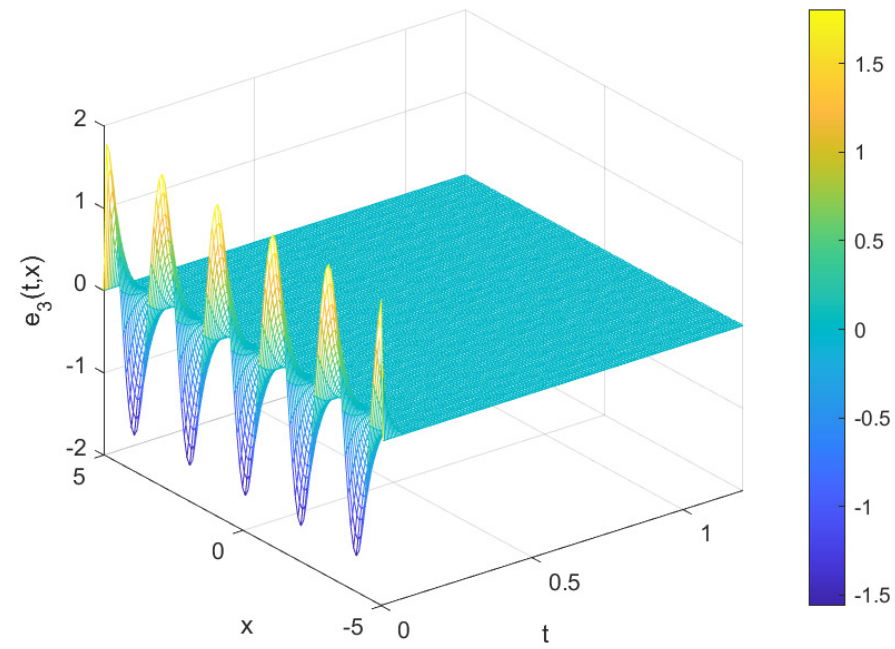
Figure 6. Time evaluation of synchronization error of e 3 ( t , x )